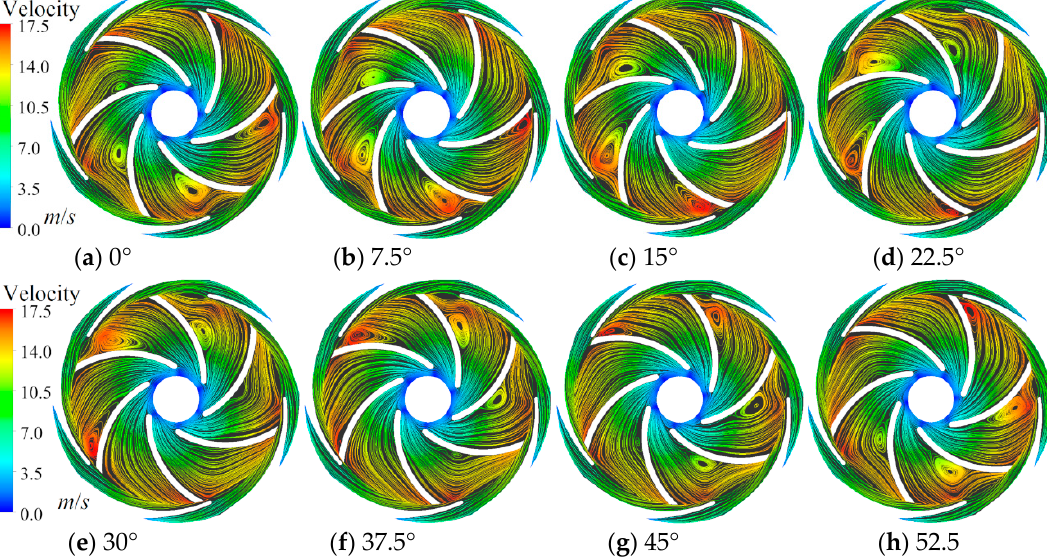
Figure 12. Evolution processes of the vortices in the stator and rotor cascade during a 1 / 6 period of impeller rotation under condition 0.6 Q d .